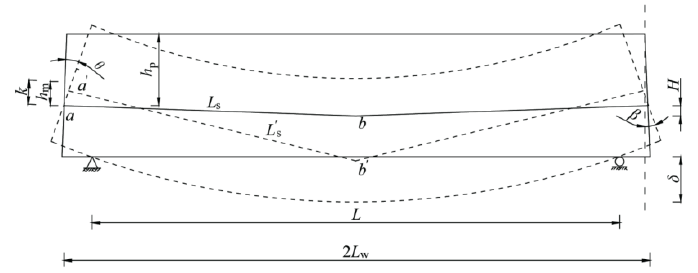
Figure 13. Calculation model of specimens.